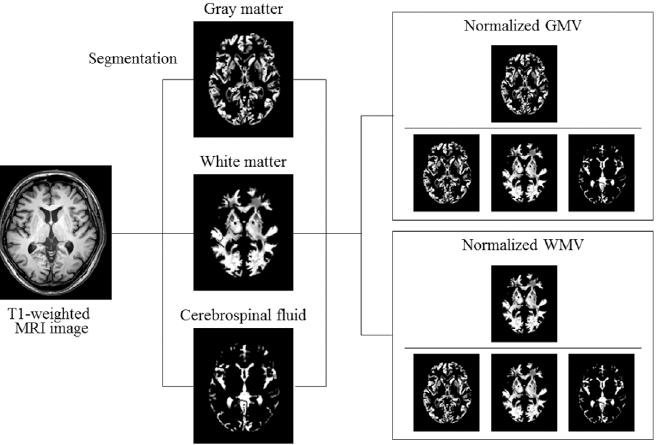
Fig 1. Segmentation of brain magnetic resonance imaging (MRI) and normalization of gray matter volume (GMV) and white matter volume (WMV). Representative axial brain image of T1-weighted MRI and segmented images of gray matter, white matter, and cerebrospinal fluid are shown. To normalize for head size variability, GMV and WMV were normalized by dividing by the total intracranial volume, calculated by adding GMV, WMV, and cerebrospinal fluid space